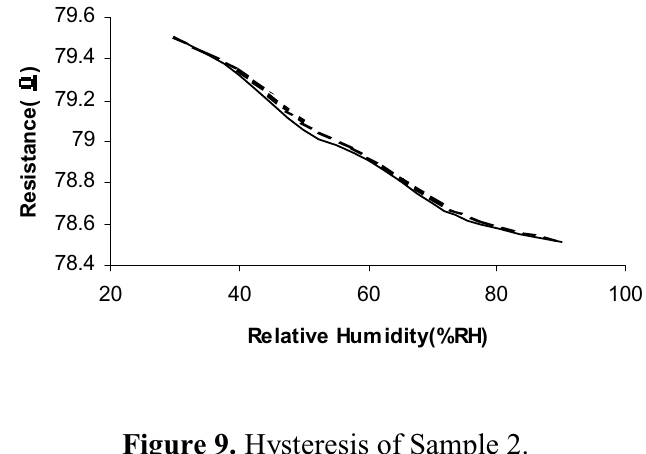
Figure 9. Hysteresis of Sample 2.